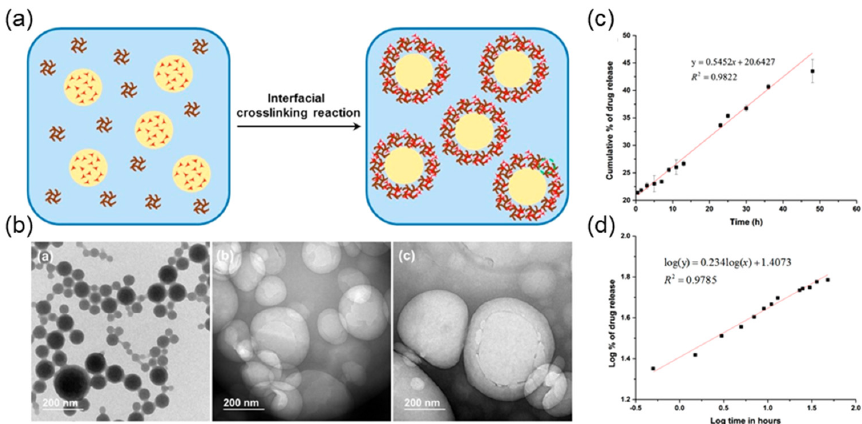
Figure 5. ( a ) Preparation of lignin-based nanocapsules via interfacial miniemulsion crosslinking reaction; ( b ) TEM images of solid particles using styrene as the oil phase in miniemulsion and lignin nanocapsules using butyl acetate as the oil phase in miniemulsion; mathematic models for coumarin-6 release: ( c ) fitting curve of zero-order release at pH 7.4; ( d ) fitting curve of Korsmeyer − Peppas model at pH 4.0. Reprinted with permission from Ref. [34]. Copyright 2016 American Chemical Society.